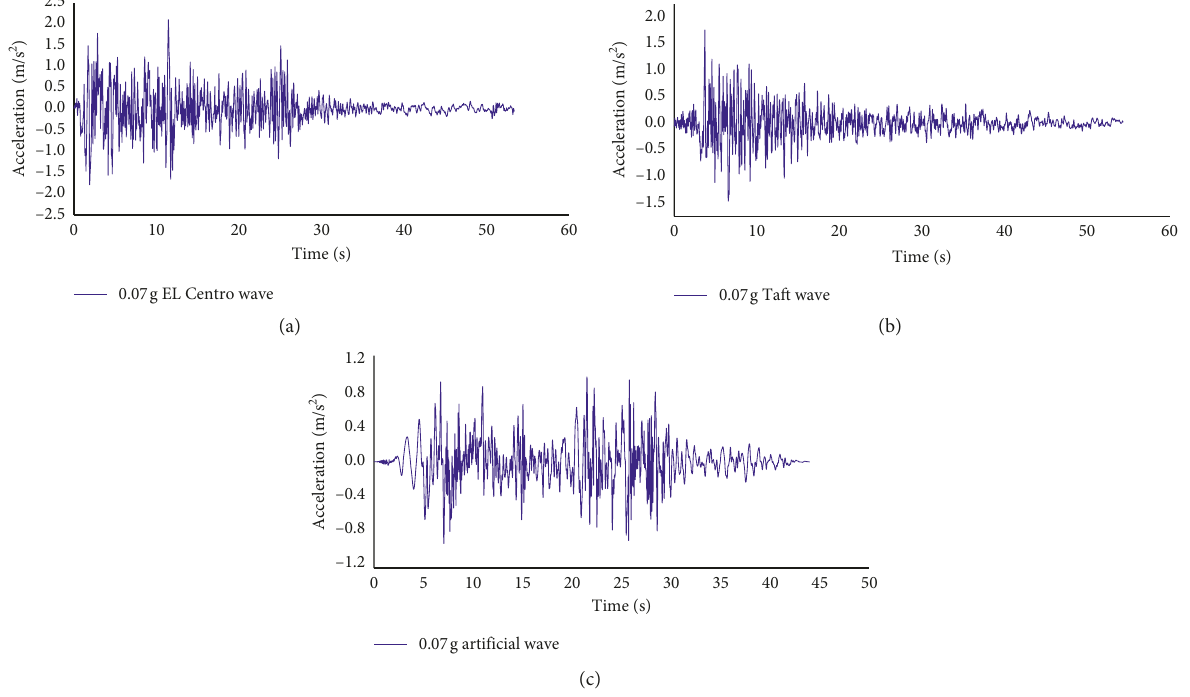
Figure 11: The 0.07g seismic records. (a) 0.07g EL Centro wave. (b) 0.07g Taft wave. (c) 0.07g artificial wave.